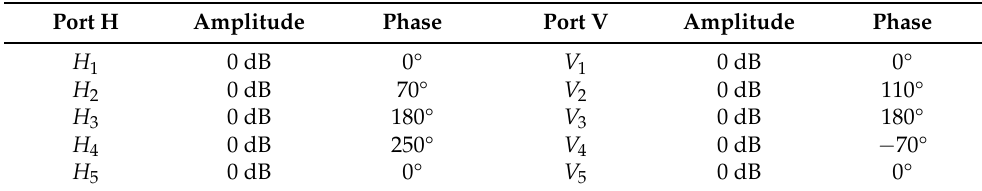
Table 5. Amplitude and phase values. Uniform amplitude and phase distribution. Array with sequential 90° rotation.